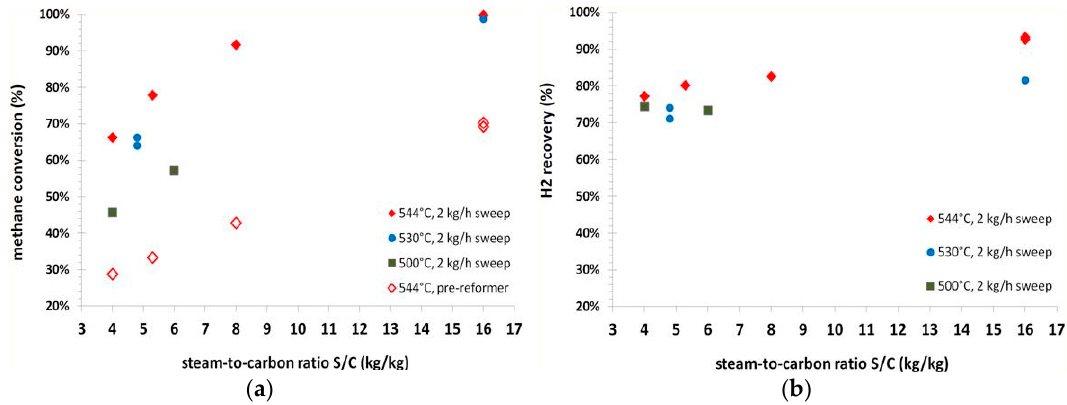
Figure 8. Effects of steam-to-carbon ratio on methane conversion ( a ) and H 2 recovery ( b ).